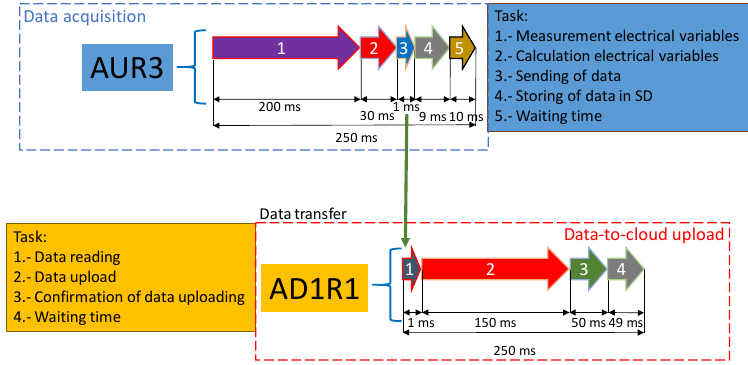
Figure 4. Process timeline for the SM.